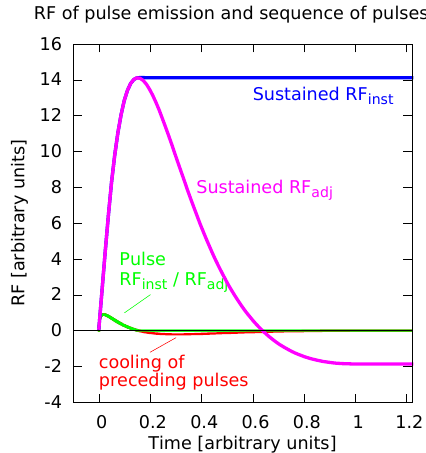
Fig. A1. Schematic view of the radiative forcing due to ozone as a result of a pulse emission of NO x compared to a sequence of pulse emissions (i.e. sustained emissions). Instantaneous and adjusted RF of a short pulse emission are identical (green). Instantaneous RF of a sequence of pulse emissions (blue) is calculated as the sum of the instantaneous RF of pulse emissions. Adjusted RF of a sequence of pulse emissions (magenta) is calculated similarly, i.e. as the sum of the RF of a sequence of pulse emissions, where the cooling effect of preceding pulses is parameterised